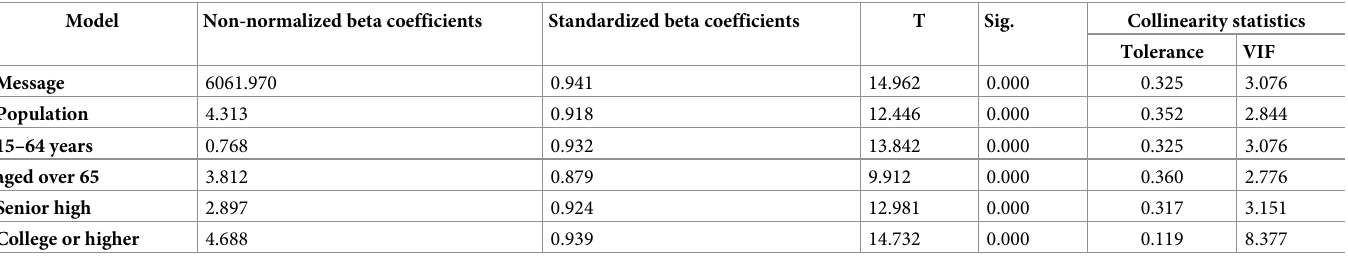
Table 3. Regression coefficients between novel coronavirus attention and influential factors.